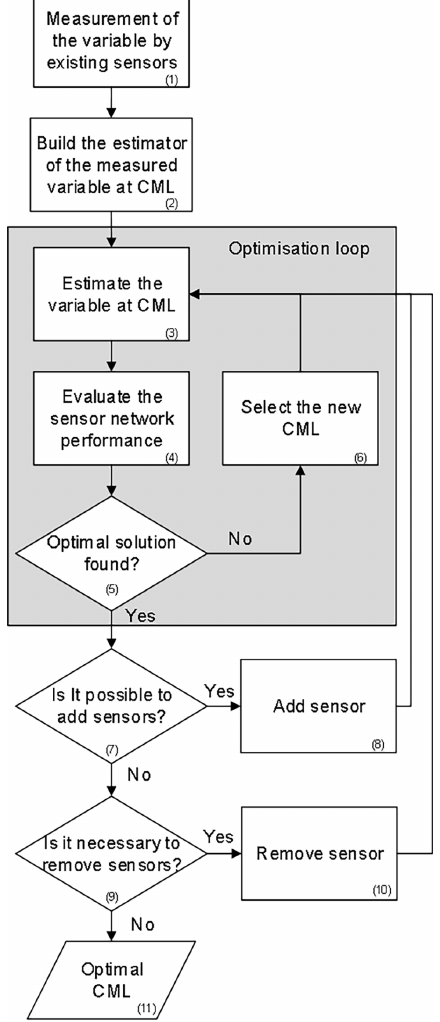
Figure 6. Sensor network (re)design flowchart (CML: candidate measurement